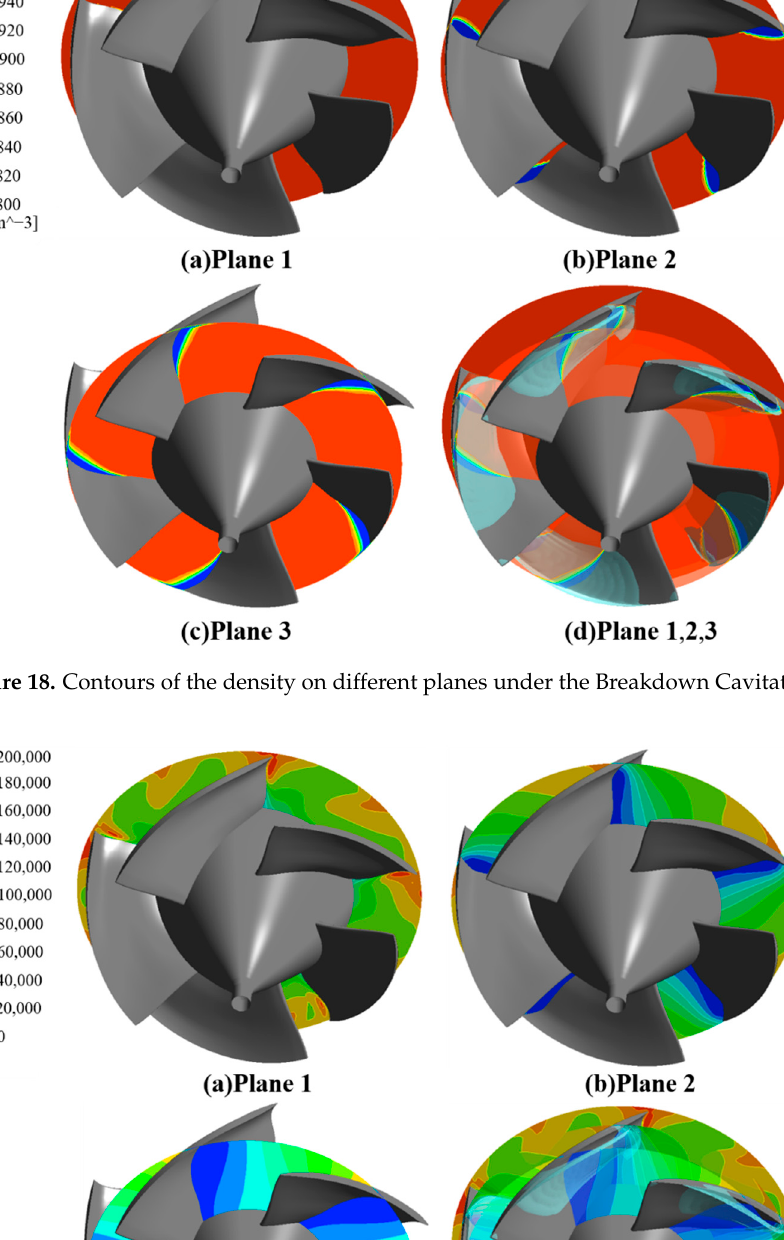
Figure 17. Selection and setting of the density and the pressure contour plane section under the Breakdown Cavitation Condition.